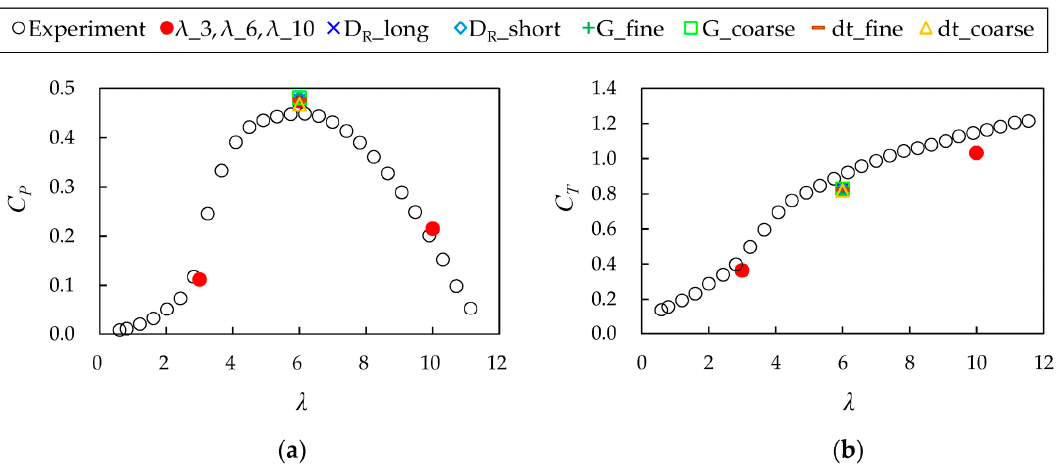
Figure 3. Computational and experimental results for the wind-turbine performance. ( a ) Power coefficient; and ( b ) thrust coefficient.